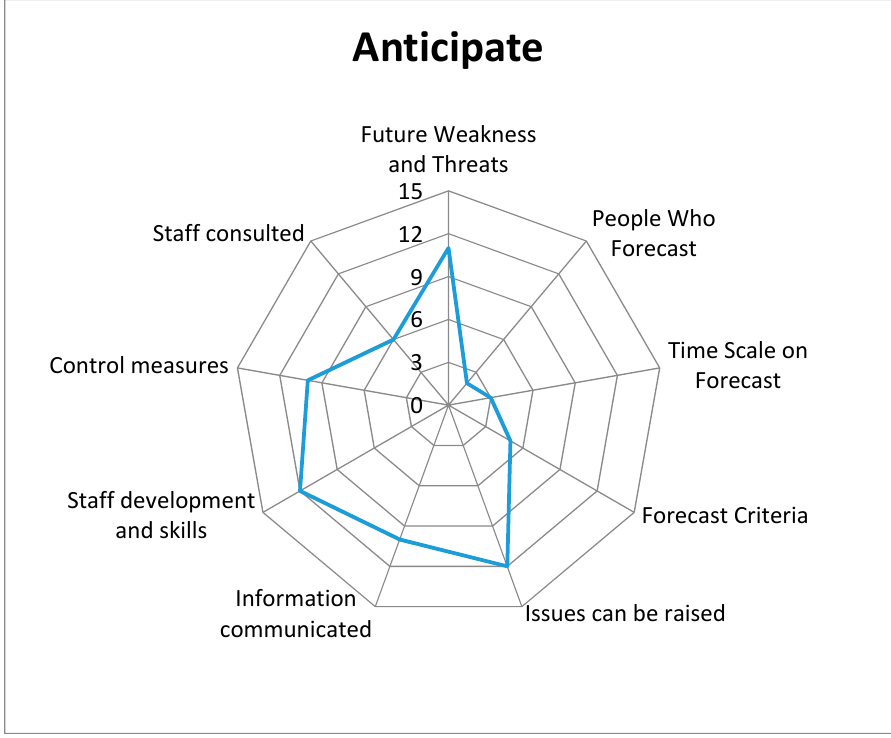
Figure 5. Potential to Anticipate—Yes responses.